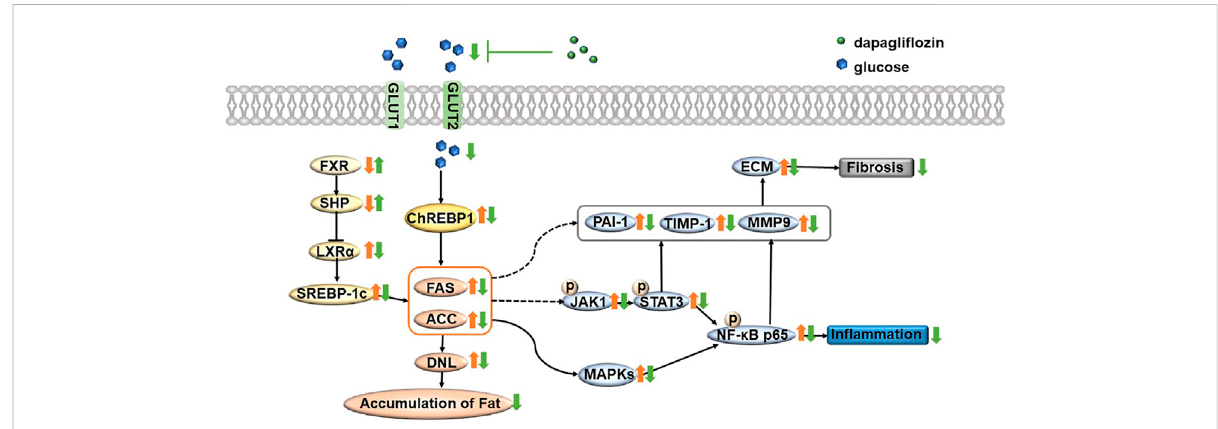
FIGURE 7 Summary of the underlying mechanism of dapagli fl ozin in alleviating nonalcoholic steatohepatitis. In brief, dapagli fl ozin treatment alleviates steatosis and reduces fat accumulation by inhibiting the FXR/SHP/LXR α /SREBP-1c pathway and reducing ChREBP1 expression in the liver of db/db mice.Inaddition,dapagli fl ozintreatmentinhibitsNF- κ Bpathwayactivationandfurtherlowersin fl ammatoryresponseviareducingtheactivityofthe MAPK pathway and JAK/STAT3 pathway. Importantly, dapagli fl ozin restores the process of fi brosis and further inhibits fi brosis by downregulating the expression of PAI-1, TIMP-1, and MMP9 in the liver of db/db mice. Orange arrows represent pathological states; green arrows represent dapagli fl ozin treatment status; FXR = farnesoid X receptor; SHP = small heterodimer partner; LXR α = liver X receptor α ; SREBP-1c = sterol regulatory element binding transcription factor; FAS = fatty acid synthase; ACC = acetyl-CoA carboxylase; ChREBP1 = carbohydrate responsive element binding protein; DNL = de novo lipogenesis; NF- κ B = nuclear factor kappa B; MAPK = mitogen-activated protein kinase; JAK =